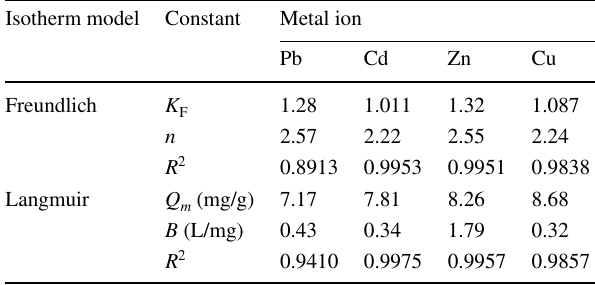
Table 3 Separation factor for the removal of Pb, Cd, Zn and Cu ions from aqueous solution Initial